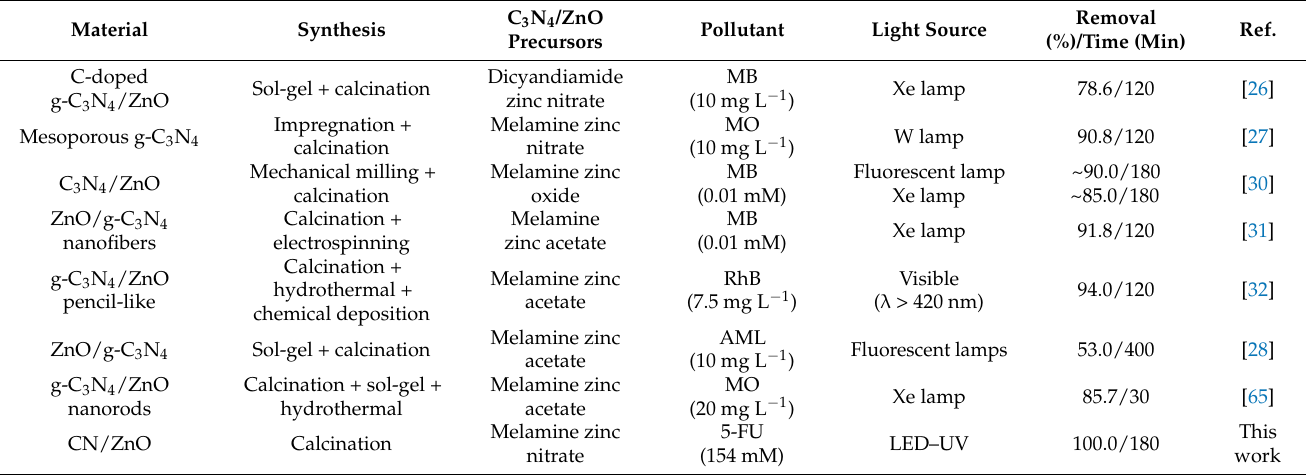
Table 3. Compilation of recently published works regarding g-C 3 N 4 /ZnO composites for the pho- todegradation of pollutants in aqueous